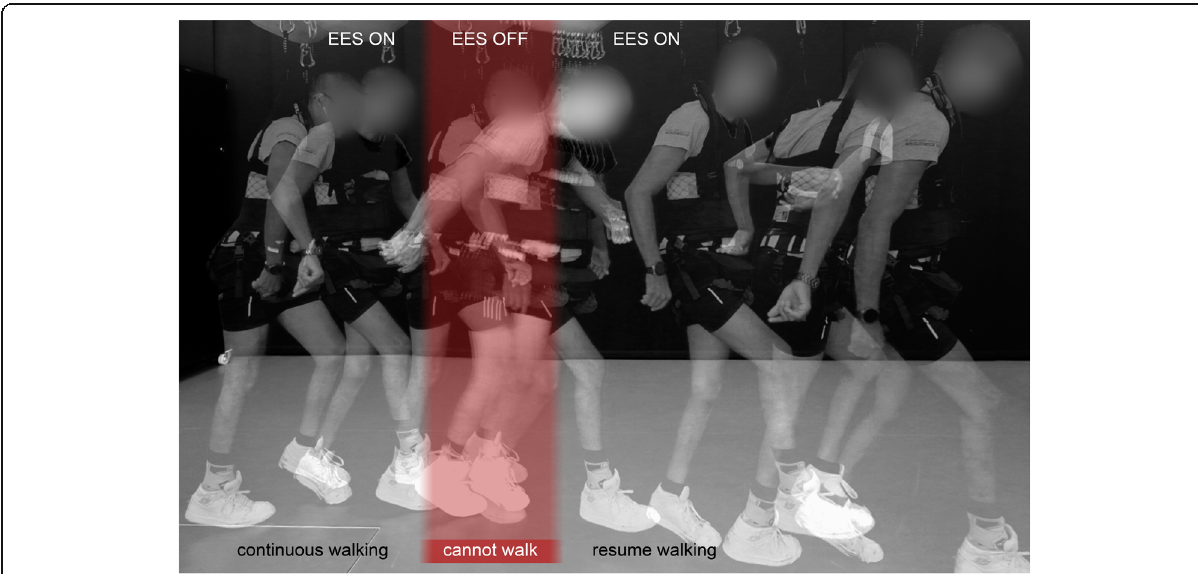
Fig. 4 Chronophotography illustrating the recovery of locomotion during targeted EES. The patient is receiving targeted EES while suspended in a cutting-edge body-weight support system. EES is switched on and off, showing that the recovery of overground locomotion only occurs during